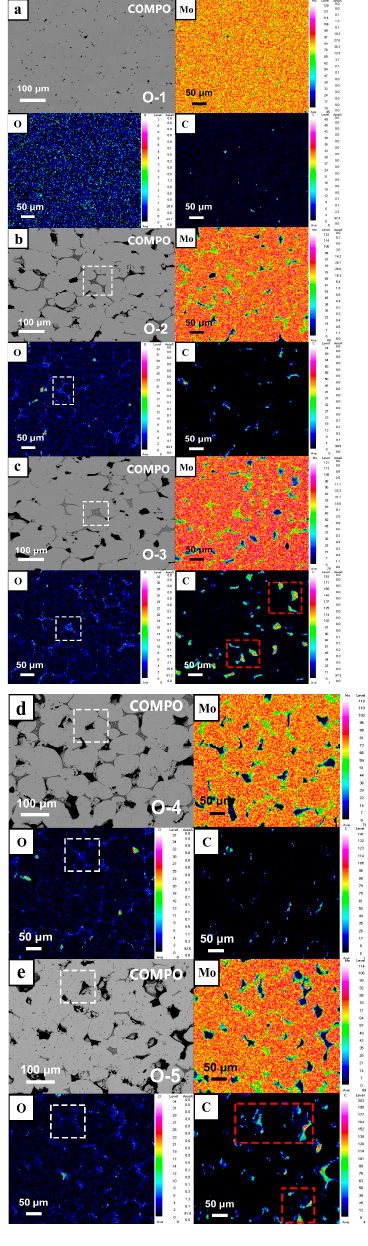
Figure 9. EPMA maps of O-1 to O-5 samples: ( a – e ) composite image and the specific Mo, O, and C elements maps. The white box represents segregation of elemental O in the grain boundary region of the Mo matrix. The red box indicates segregation of the C element in the pores of the Mo matrix.